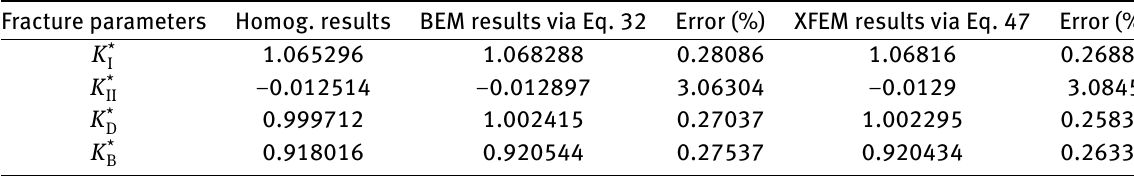
Table 1: Fracture parameters of a MEE interface crack for V I f = V II f = 0.5 Fracture parameters